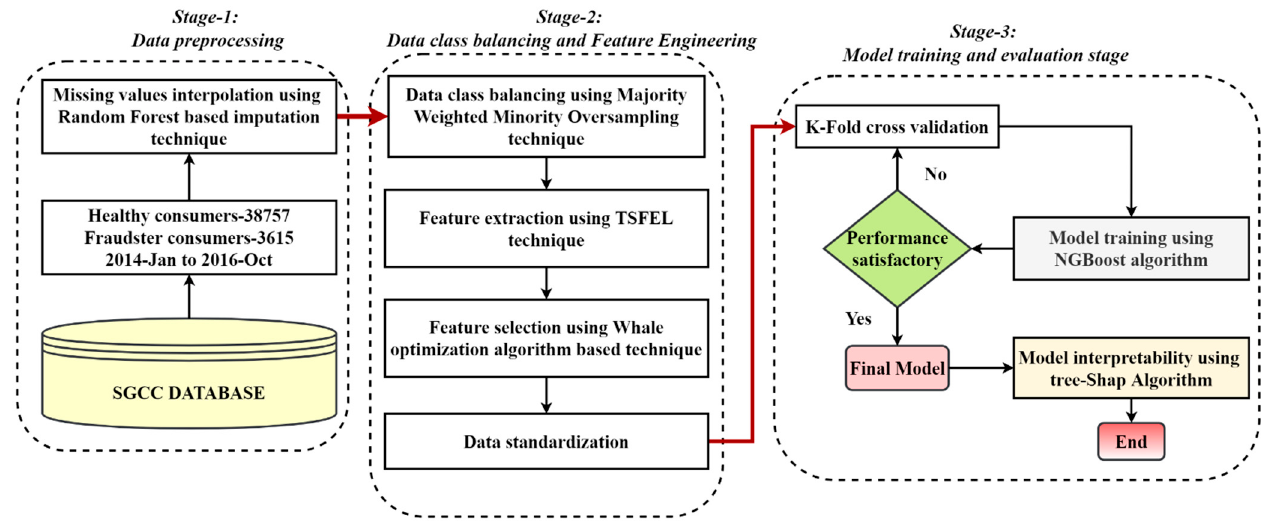
Figure 2. The simplified flow chart of the proposed feature-engineered–NGBoost classifier for electric theft detection.